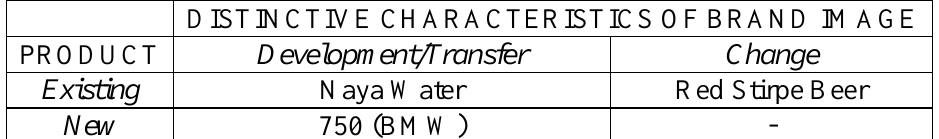
Table 2: Product Placement and Distinctive Characteristics of Brand